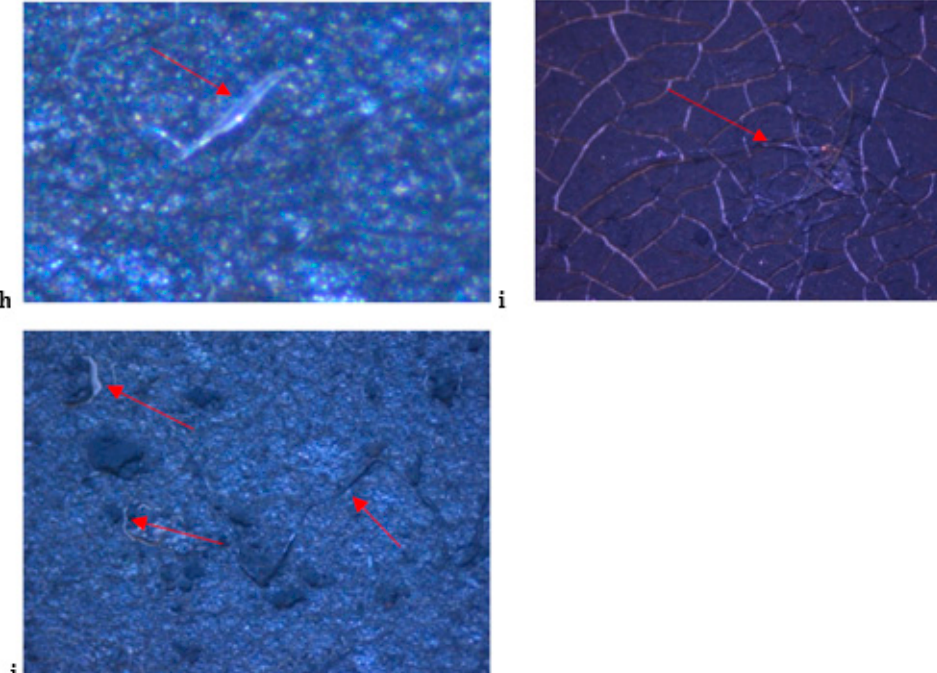
Figure 3. Stereo microscope images of microplastics filtered with PVDF/CNOs membranes from ( a –